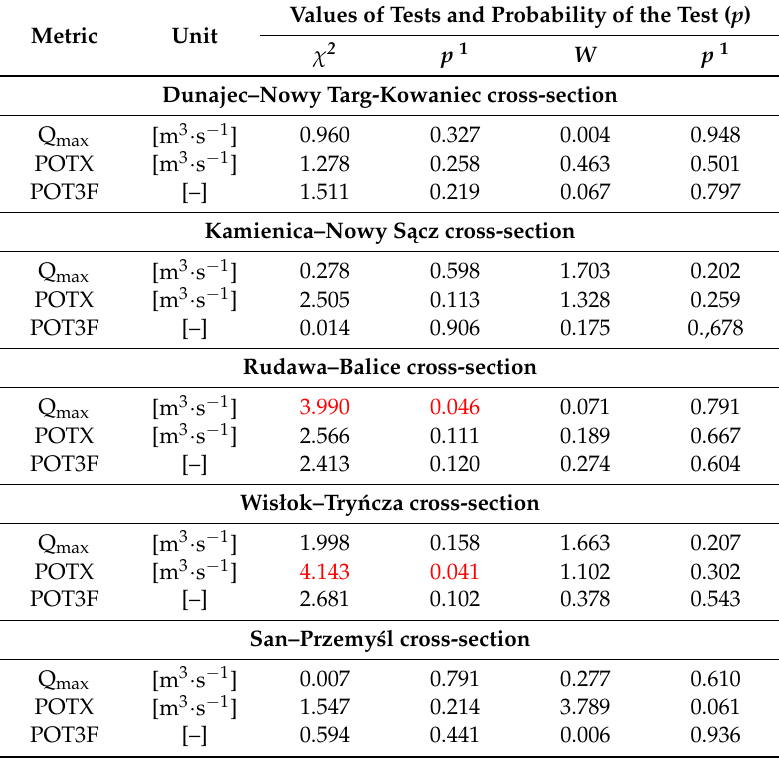
Table 3. F and χ 2 statistics for the selected high water stage metrics in the investigated river catchments. Values of Tests and Probability of the Test ( p ) Metric Unit χ 2 p 1 W p 1 Dunajec–Nowy Targ-Kowaniec cross-section Q max [m 3 · s − 1